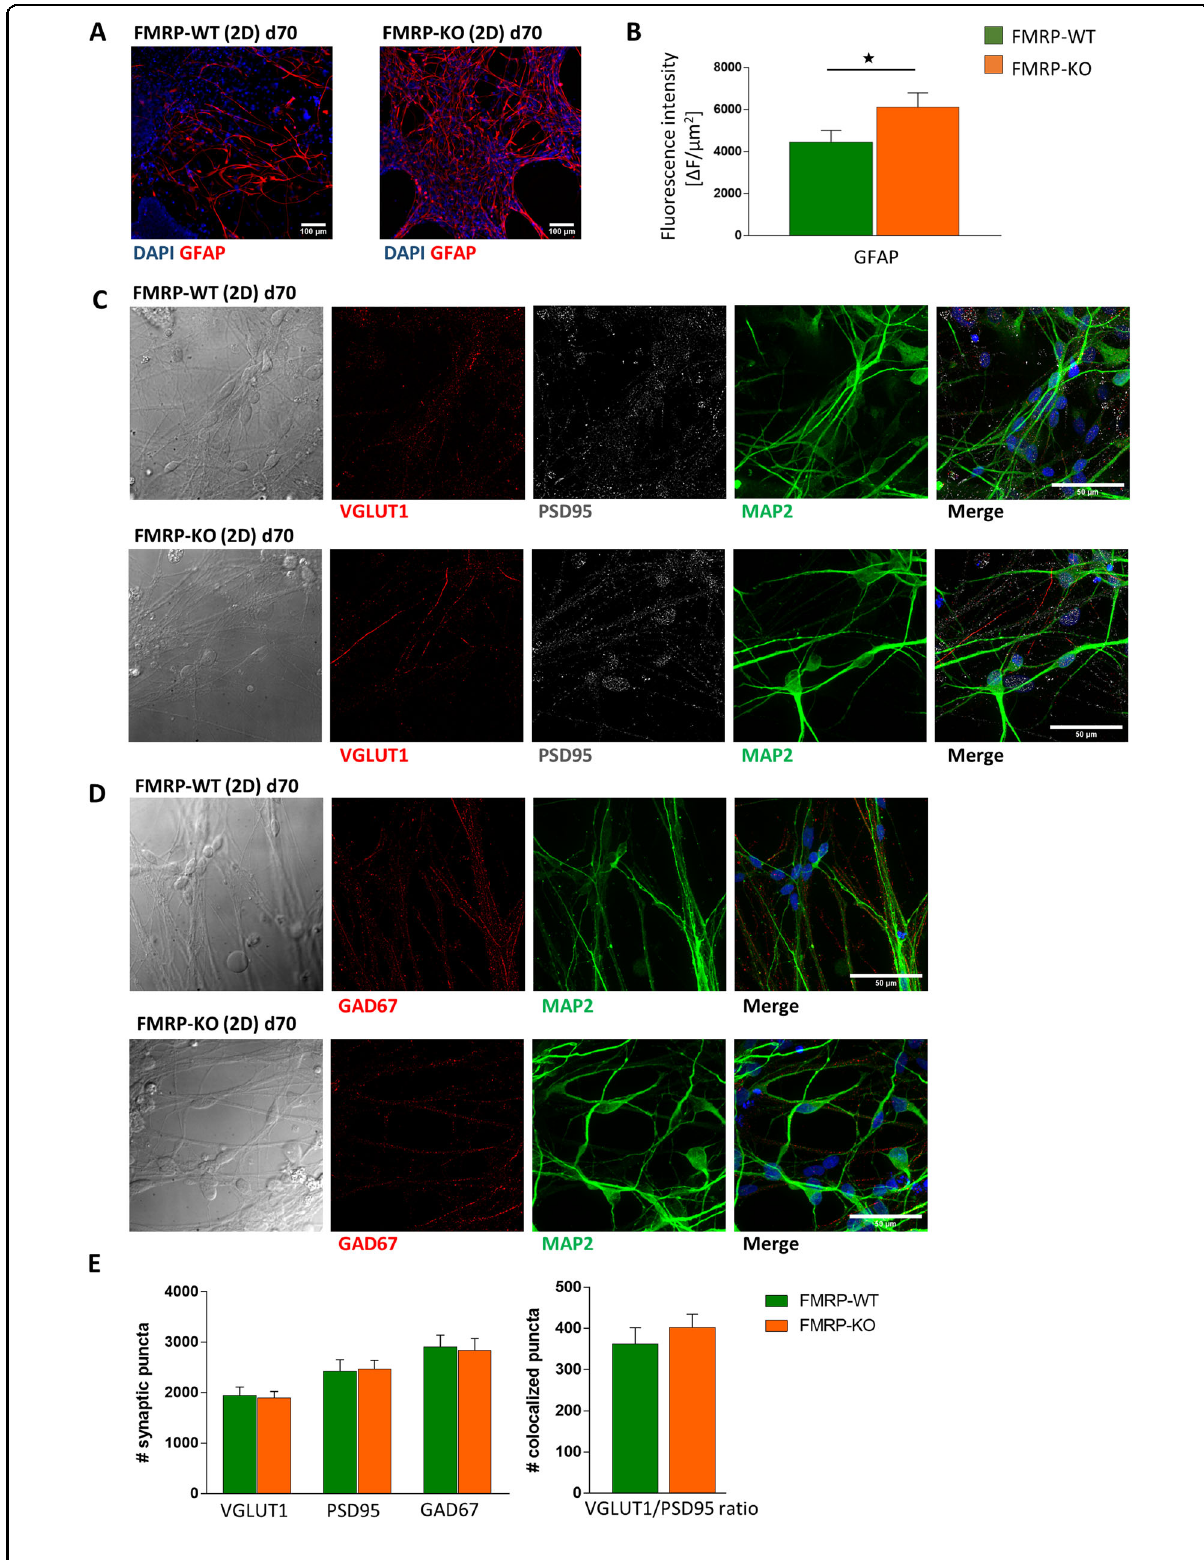
Fig. 4 (See legend on next